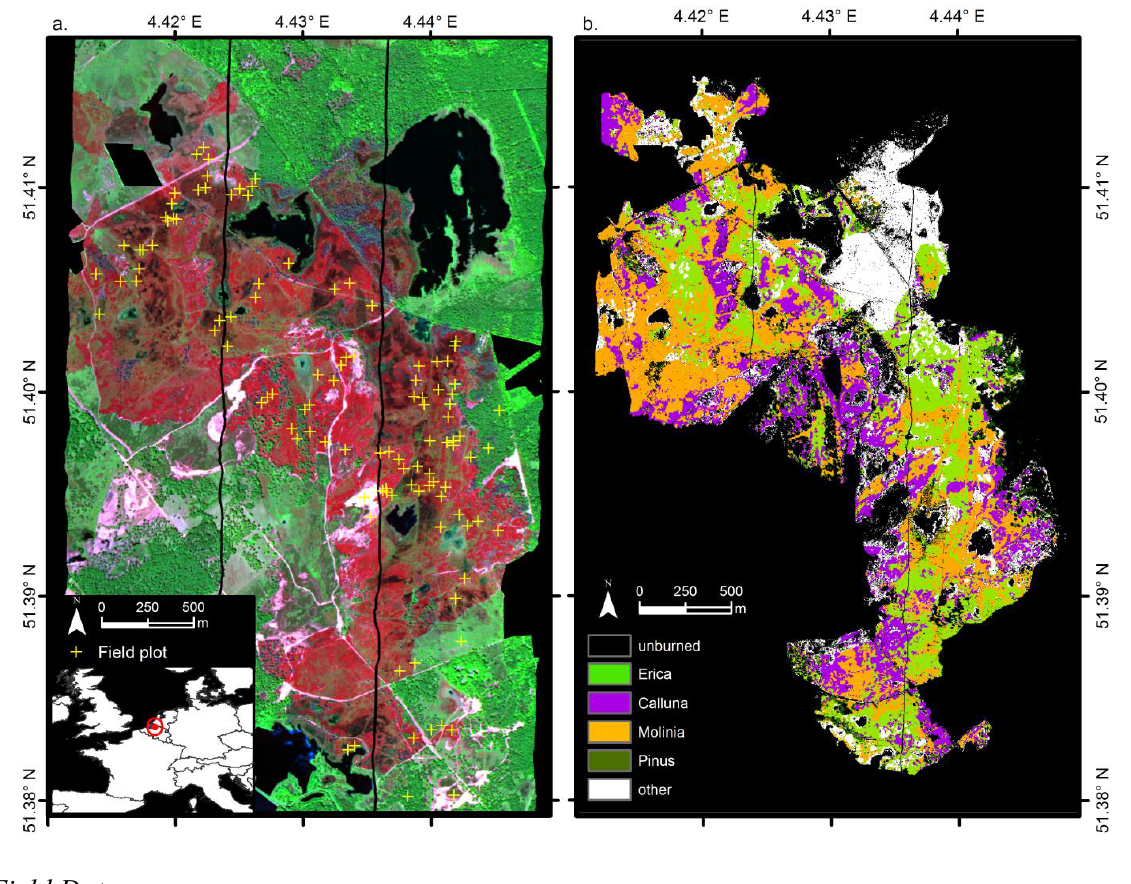
Figure 1. ( a ) False color composite (RGB: LSWIR: 2332 nm; NIR: 801 nm, R: 699 nm) of the APEX image of 27 June 2011, over the Kalmthoutse Heide , showing the 2011 burn scar. Locations of field plots are indicated (yellow plus signs). The two north-south oriented black lines are the result of on-board calibration to measure dark current during acquisition (see Section 2.3). ( b ) pre-fire vegetation types within the burn scar (see Section